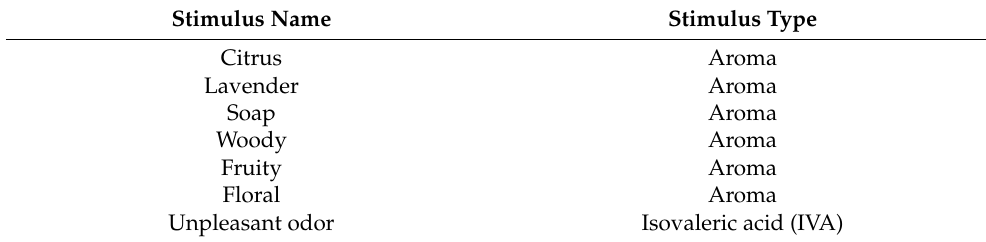
Table 1. Olfactory stimuli used in the experiment.